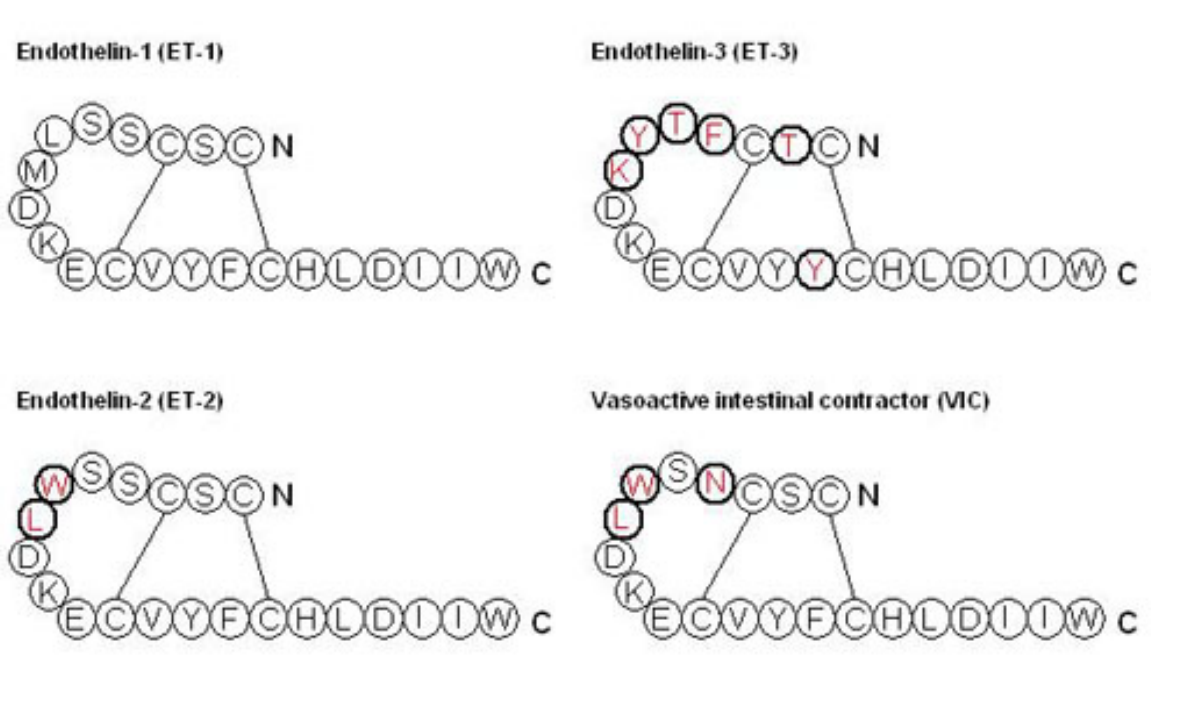
FIGURE 1. Structures of ET family peptides. Lines indicate disulfide bridges. Bold circles with red font indicate differences from ET-1 among amino acid residues. The peptide sequences are derived from mouse and rat (ET-1, VIC, and ET-3) or human (ET-1, ET-2, and ET-3) species,